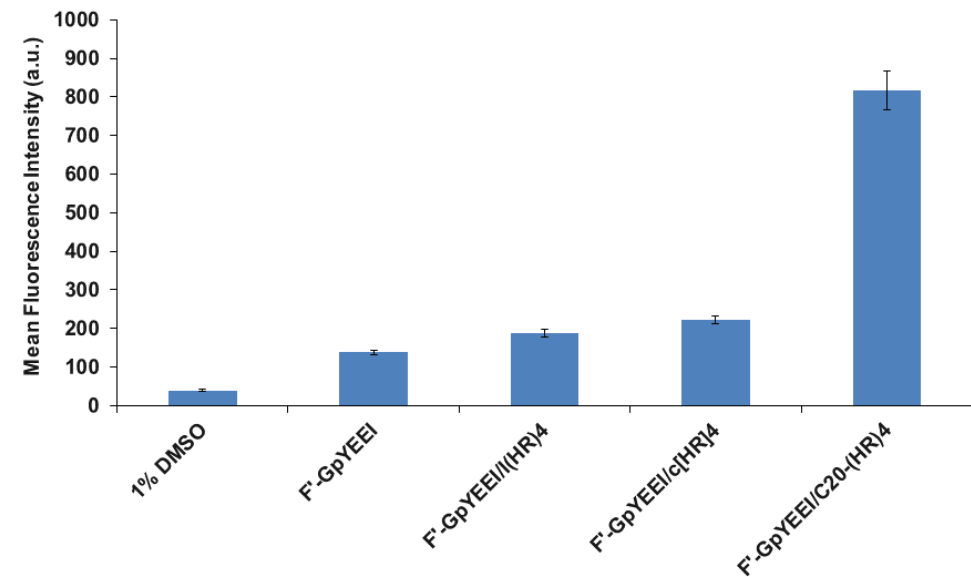
Figure 7. Comparative study for the cellular uptake of F’-GpYEEI (5 µM) by l(HR) 4, c[HR] 4 , and C 20 -(HR) 4 at 50 µM in SK-OV-3 cell line.